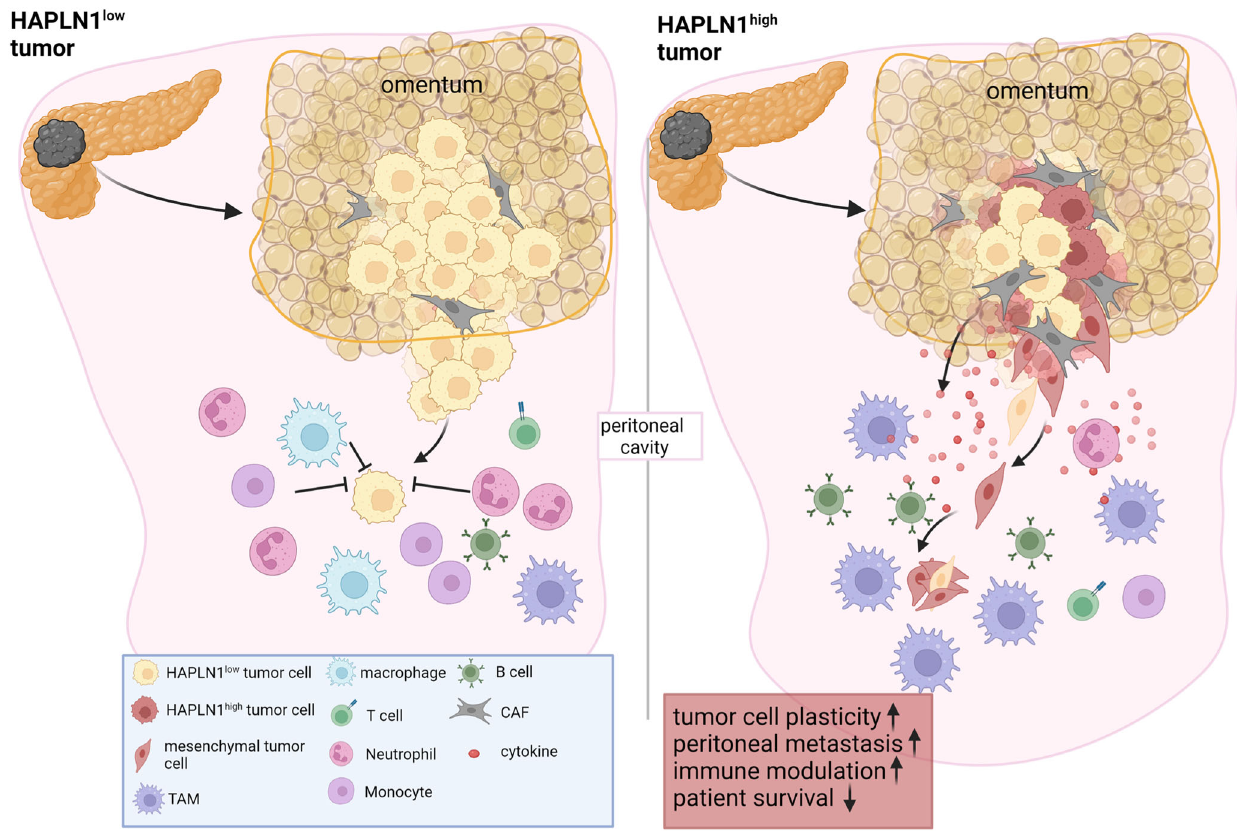
Fig.8|HAPLN1drivesperitonealcarcinomatosisbyinducingcellplasticity. We propose that in HAPLN1 low conditions tumor cells are less equipped to survive in the peritoneal cavity due to a decreased migratory capacity and a tumoricidal